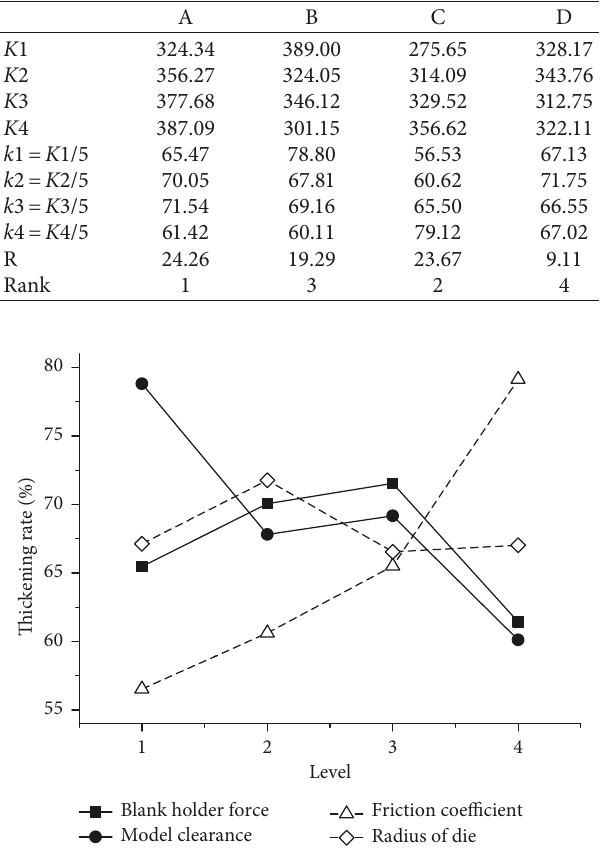
Figure 6: Influence trend of factors on the maximum thickening rate at different